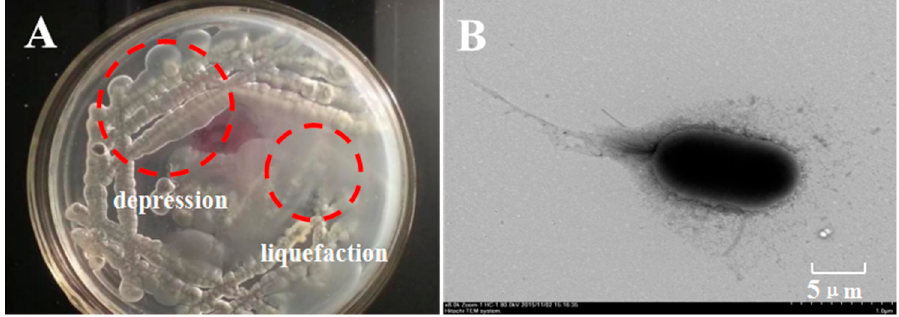
Figure 1. ( A ) The appearance of liquefaction and depression on plate medium and ( B ) the TEM image of Thalassospira sp. Fjfst-332.